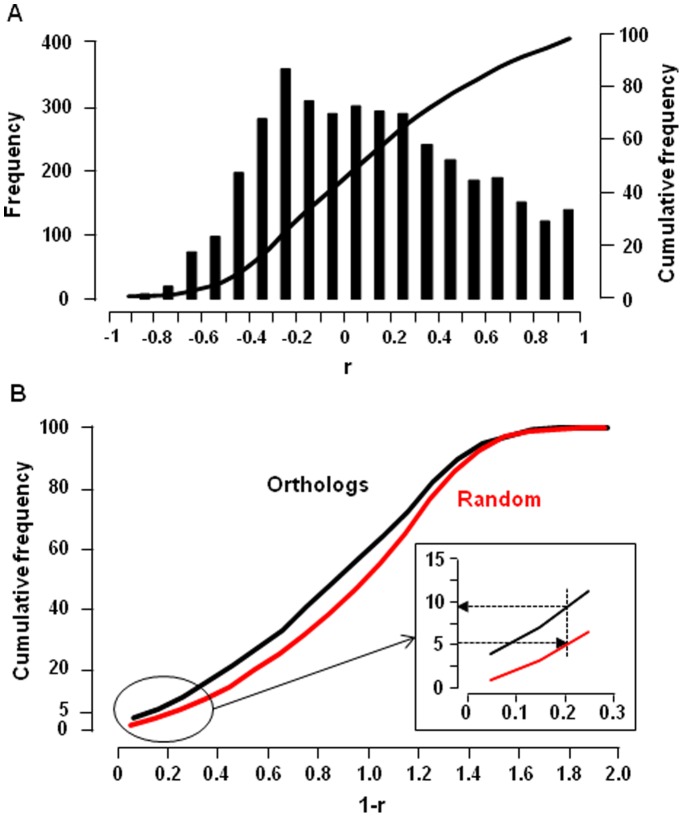
Comparison of gene expression profiles in human and mouse nephron.
A. The columns show the histogram of distribution of the Pearson’s correlation coefficients (r) of the 4644 genes in the HMKS database. The curve shows the cumulative fraction. B. The curves show the cumulative distribution of Pearson’s distances (1-r) for pairs of orthologous genes and random-paired genes. The inset shows that 9.5% of orthologous transcripts displayed a Pearson’s distance smaller than that of the 5% random pairs of transcripts with the lowest Pearson’s distances.